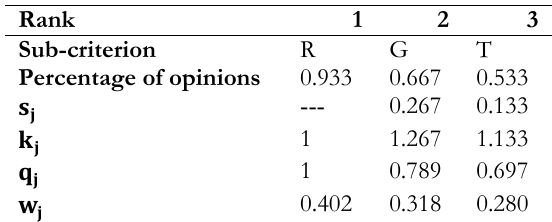
Table 20. Values of 𝐬 𝐣 , 𝐤 𝐣 , 𝐪 𝐣 and 𝐰 𝐣 .